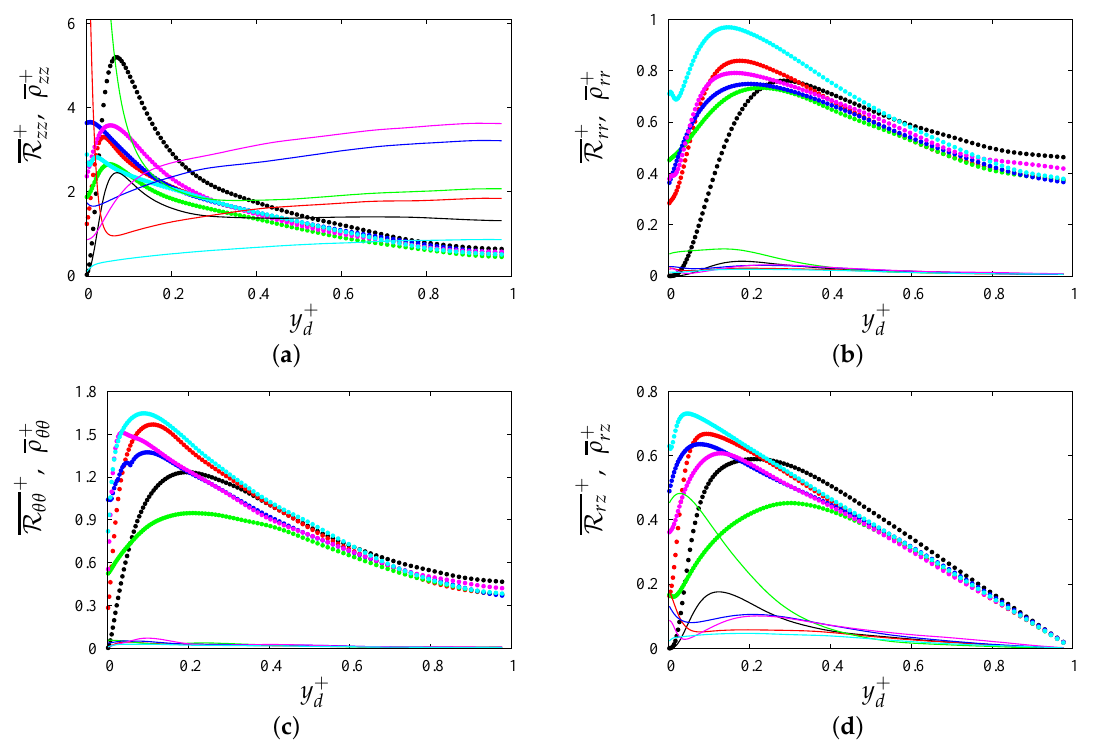
Figure 6. Profiles of incoherent stresses R ij (symbols)(, and of the coherent stresses ρ y d from the plane of the crests, for the corrugations indicated in the legend of Figure 4b: ( a ) axial, ( b ) radial, ( c ) azimuthal, and ( d ) shear